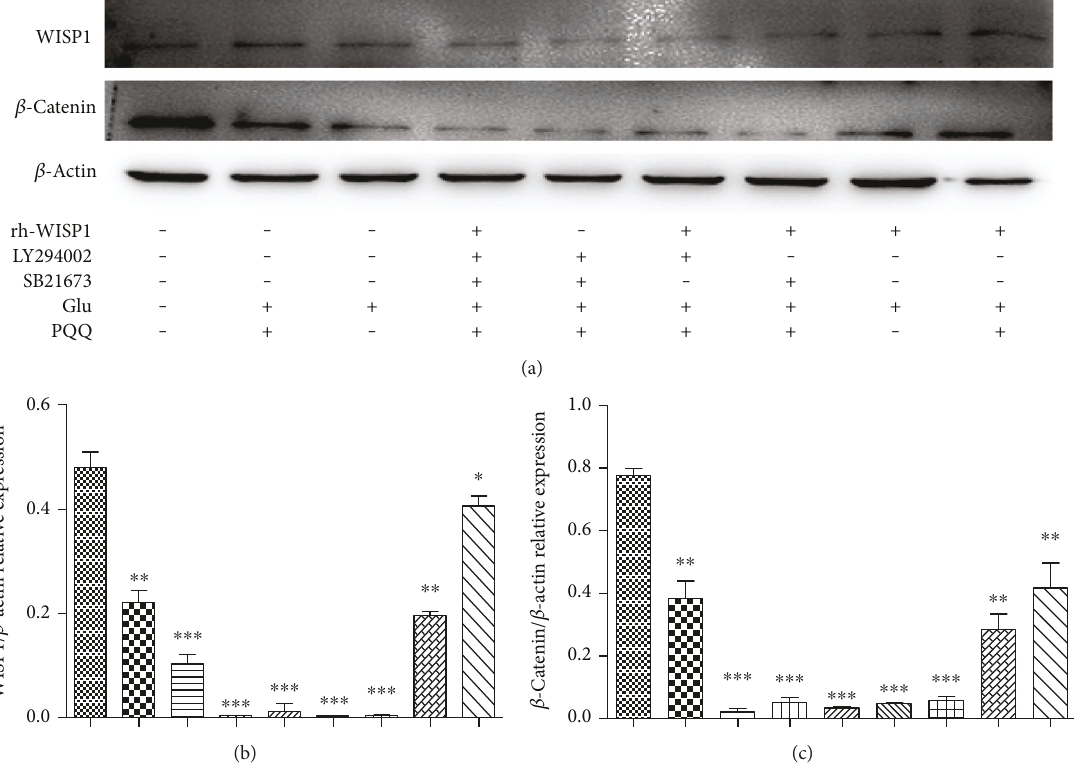
Figure 9: WISP1 and β -catenin protein expression after blocking PI3K/GSK-3 β signaling pathway ( ∗ P < 0 05 , ∗∗ P < 0 01 , ∗∗∗ P < 0 001 versus sham).